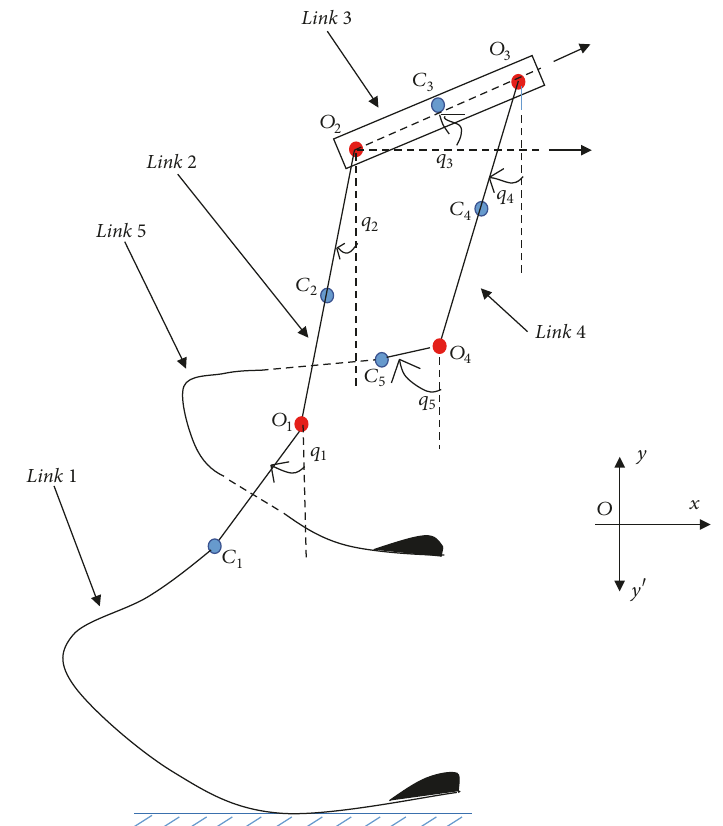
Figure 7: Model of AR with variables are referenced to the vertical